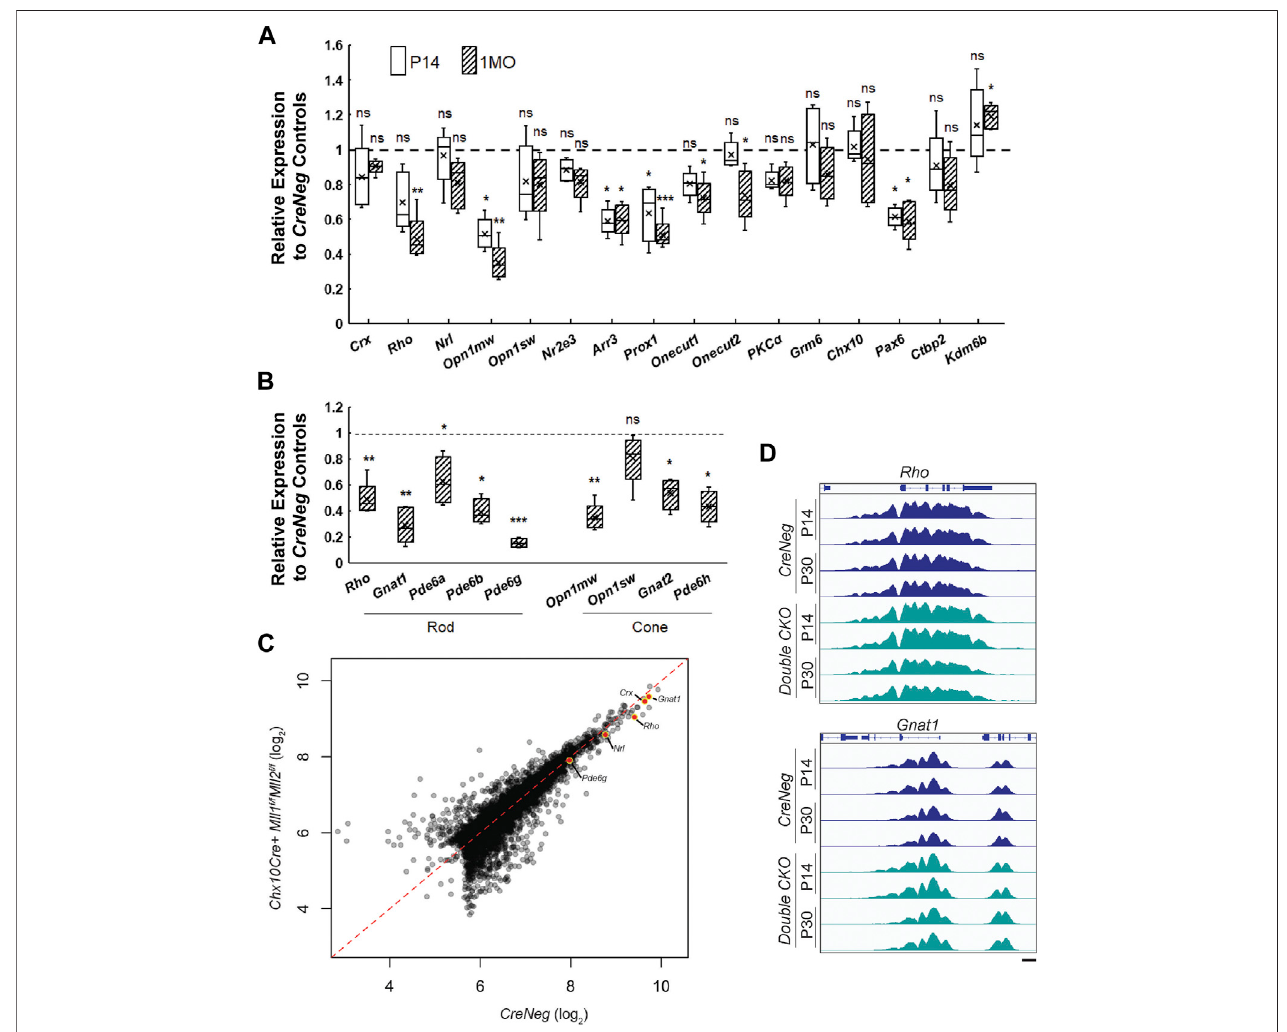
FIGURE 6 | Gene expression pro fi le in P14 and 1MO Chx10Cre + Mll1 f/f Mll2 f/f . (A) qRT-PCR analysis of selected genes in P14 and 1MO Chx10Cre + Mll1 f/f Mll2 f/f retinae.Results areplottedasrelative expression to Chx10Cre - ( CreNeg )littermate controls( n ≥ 4). (B) qRT-PCRanalysisofphototransduction geneexpression in1MO Chx10Cre + Mll1 f/f Mll2 f/f retinae. Results areplotted as relative expression to Chx10Cre - ( CreNeg ) littermate controls ( n ≥ 4). Asterisks (*,**, ***) denote p ≤ 0.05, p ≤ 0.01, p ≤ 0.001respectivelybyone-wayANOVAwithTukey ’ smultiplecomparisons,andnsmeansnotsigni fi cant. (C) QuantitativecomparisonofdatafromallH3K4me3 peaks in 1MO CreNeg and Chx10Cre + Mll1 f/f Mll2 f/f datasets. Promoter peaks of key phototransduction genes are highlighted. (D) ChIP-Seq data from P14 and 1MO Chx10Cre + Mll1 f/f Mll2 f/f and CreNeg retinae for H3K4me3 shows no differences at key rod phototransduction loci.